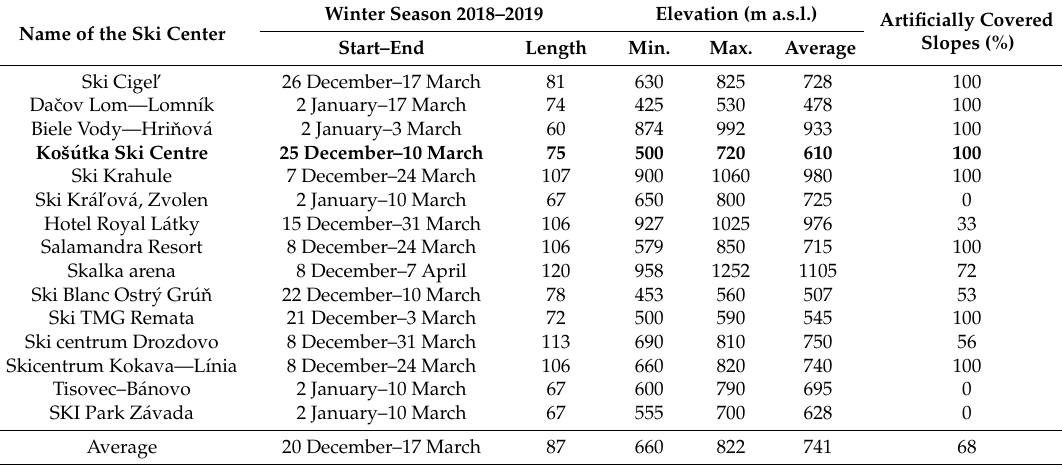
Table 1. Characteristics of the South-Central Slovakian ski centers. Probable start/end of the expected winter season 2018–2019, determined according to www.onthesnow.sk [29]. Artificially covered slopes = the percentage of the artificially covered ski slopes. Investigated ski center highlighted in